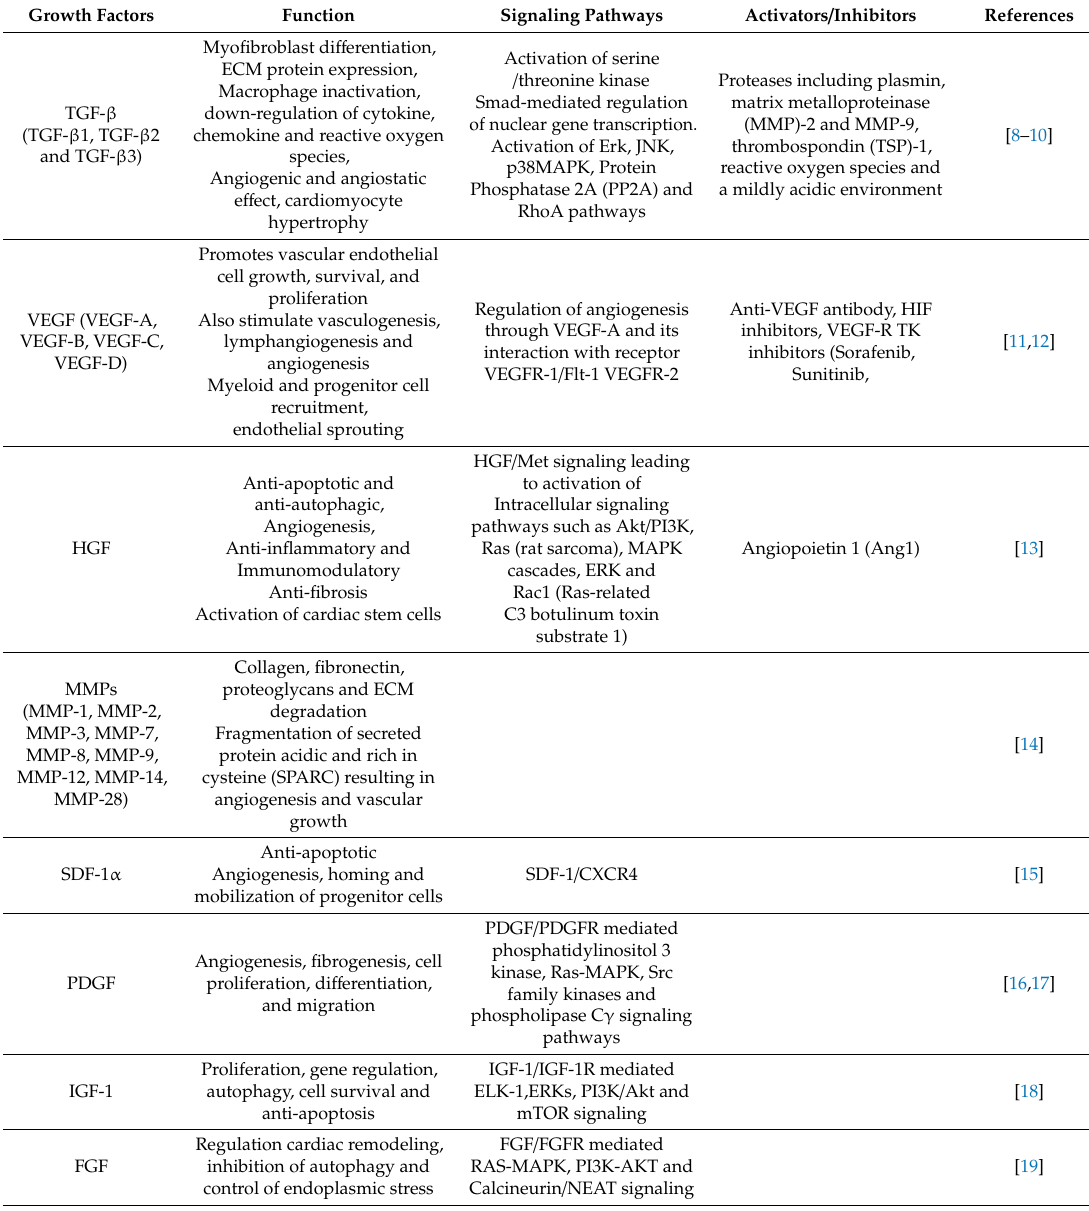
Functionalities and signaling pathways of regenerative cellular growth factors. IGF: Insulin growth factor, MMP: matrix metalloproteinase, PDGF: platelet-derived growth